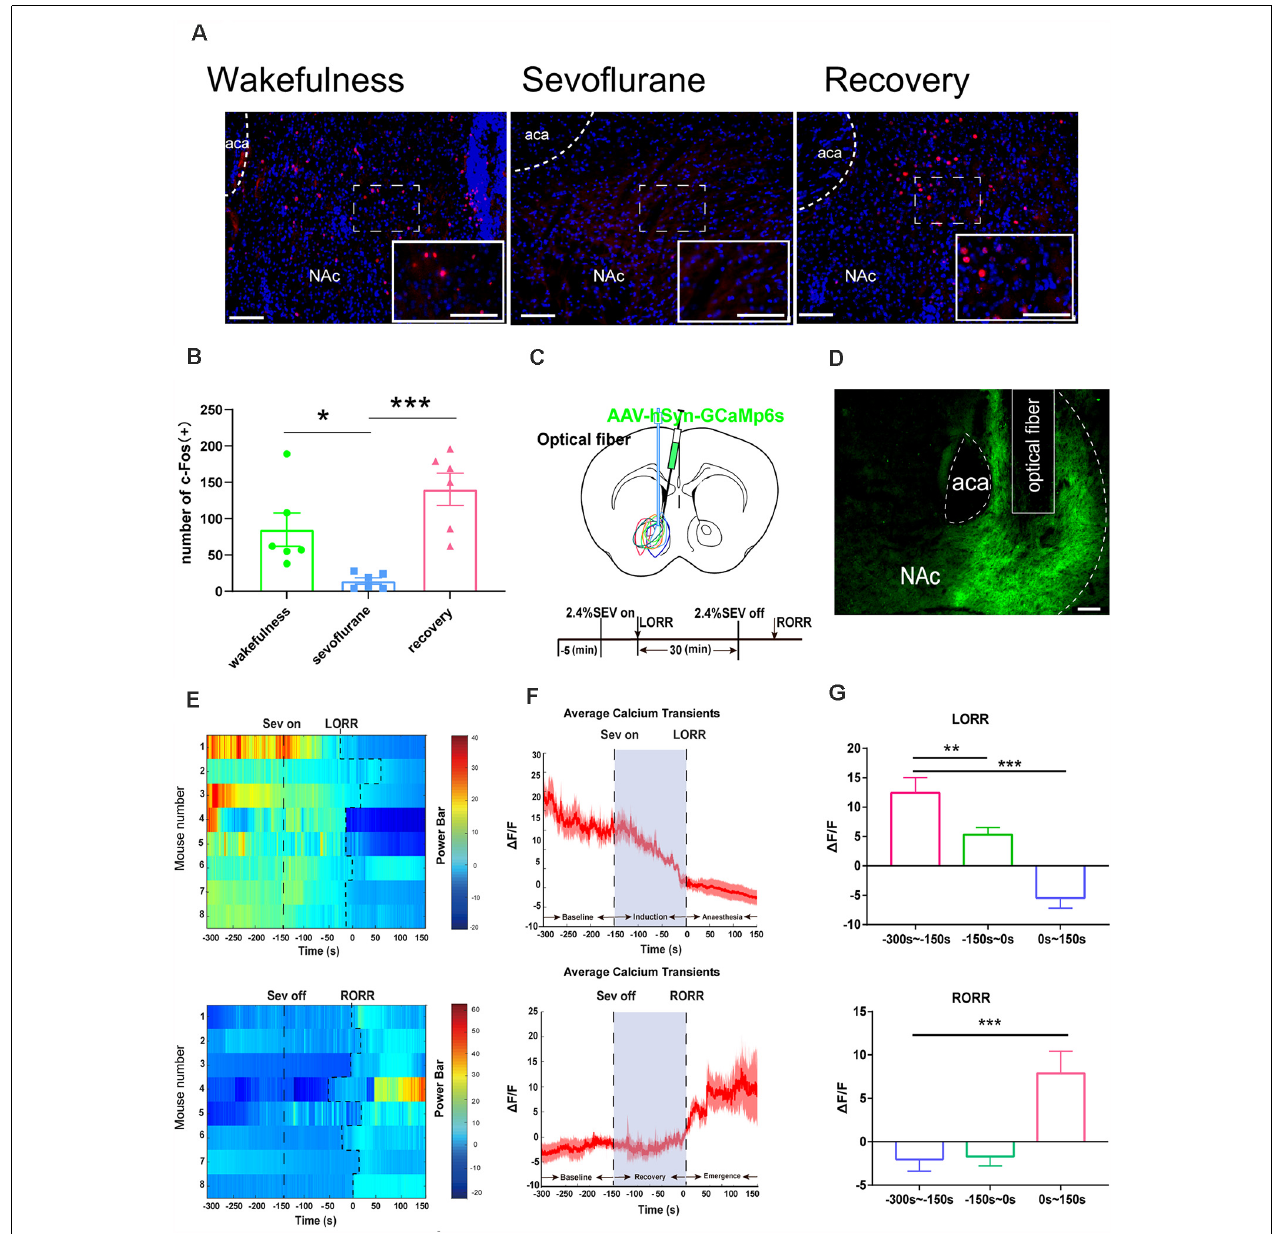
FIGURE 4 | Nucleus accumbens (NAc) neuron activity and neural dynamics in response to sevoflurane. (A) Expression of c-Fos in the NAc in the wakefulness state, sevoflurane anesthesia and recovery from anesthesia in mice (Scale bars: 200 µ m. (B) Average number of c-Fos-immunopositive neurons. One-way ANOVA followed by post hoc Bonferroni’s test. n = 6, * p < 0.05, *** p < 0.0001. (C) Expression of GCaMP6s in NAc neurons. (D) Expression of the DA2h virus in the NAc area (Scale bars: 200 µ m). (E) Heat map illustrating the changes in the Ca 2+ signals related to sevoflurane-induced LORR and RORR. (F) Average calcium transients associated with LORR and RORR; mean (red trace) ± SEM (red shading). (G) ∆ F/F represents the deviation in Ca 2+ fluorescence from the baseline, which is the averaged ∆ F/F between t = –300 s and –150 s. Data are presented as the mean ± SEM. * p < 0.05, ** p < 0.01, n = 8, by paired t